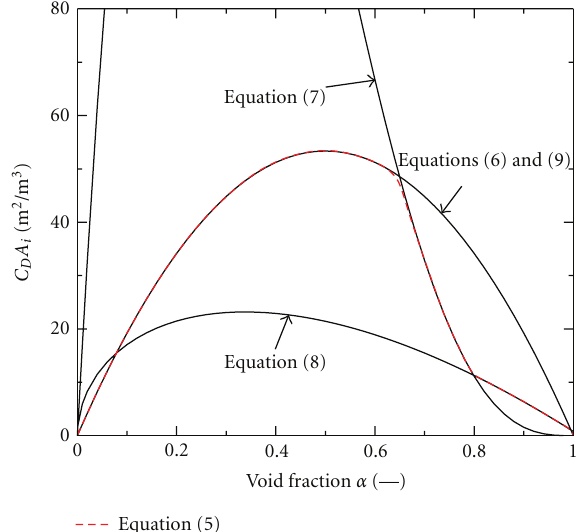
Figure 3: Interfacial drag coe ffi cients ( D h = 0 . 0254 m). on correlations for slug flow [15] and annular flow [2], respectively. Equation (7) was simplified from the original correlation by Ishii and Mishima [15] using α gs = 0, where α gs is void fraction of small bubbles. In (6), drift velocity V gj (m/s) for stagnant liquid, which was simplified from the original correlation [16], was used: V gi = 1 .